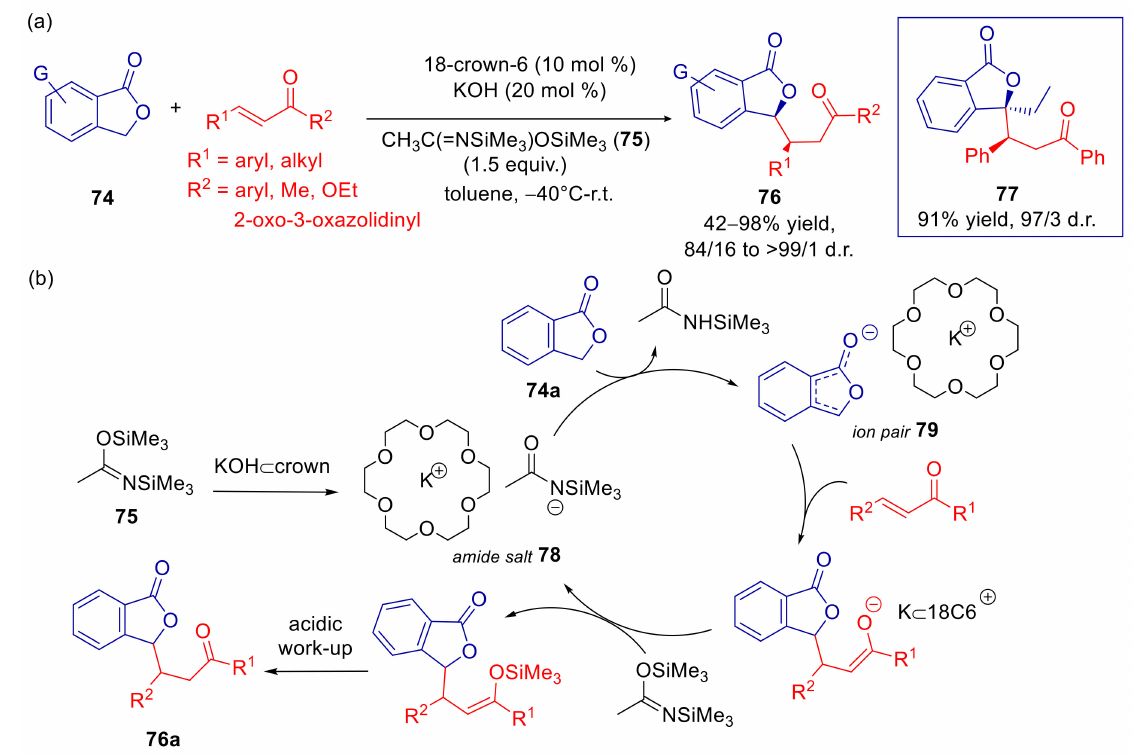
Scheme 25. Diastereoselective arylogous Michael reaction of 3-unsubstituted and 3-alkyl substituted phthalides with α , β -unsaturated carbonyl compounds, catalyzed by KOH/18-crown-6. ( a ) Scope of reaction; ( b ) Plausible